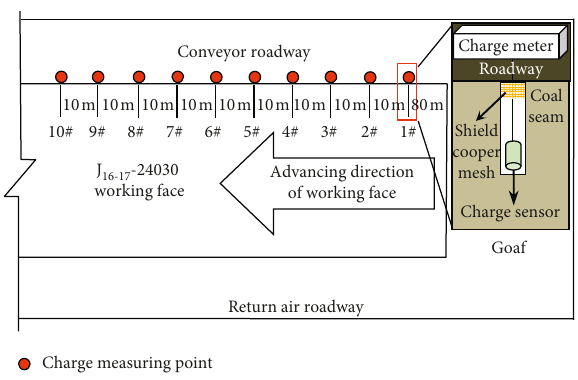
Figure 9: Charge monitoring point layout map.